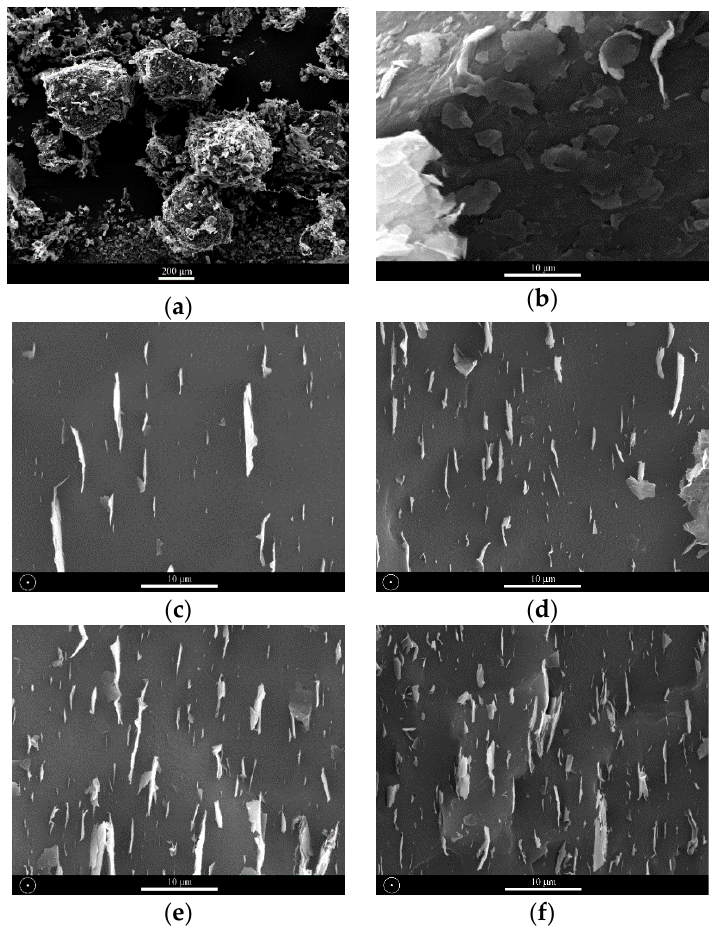
Figure 4. SEM images of LDPE powder coated with GnP ( a , b ) and freeze-fractured surfaces of nanocomposites filled with respectively 1%, 3%, 5% and 7.5% of GnP ( c – f ). Extrusion direction is indicated by circles.